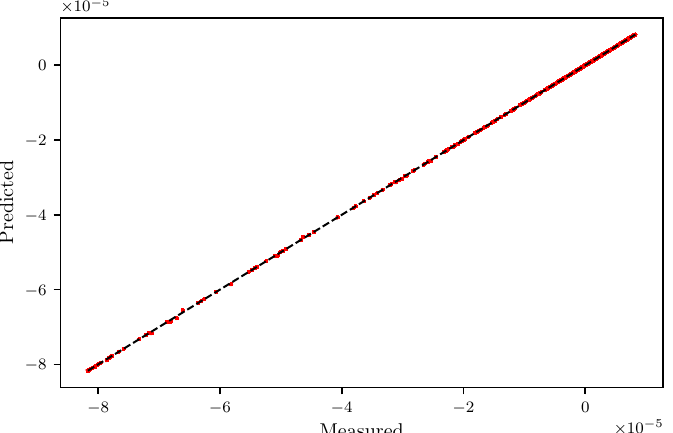
Figure 2. Parity plot of cross-validated predictions against “ground truth” values for the Decision Tree algorithm.